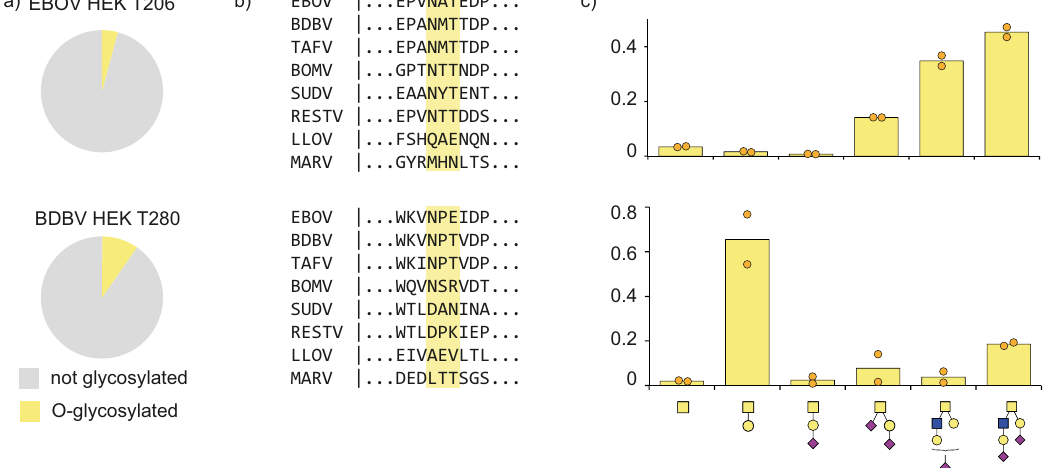
Fig. 5 O-linked glycosylation outside the MLD in ebolavirus GP. a Pie charts represent the occupancy of the O-linked modi fi cation. b Sequence conservation of the detected O-linked glycosylation sites. c Distribution of glycan types at the indicated sites (bars indicate average of both replicate measurements shows as solid